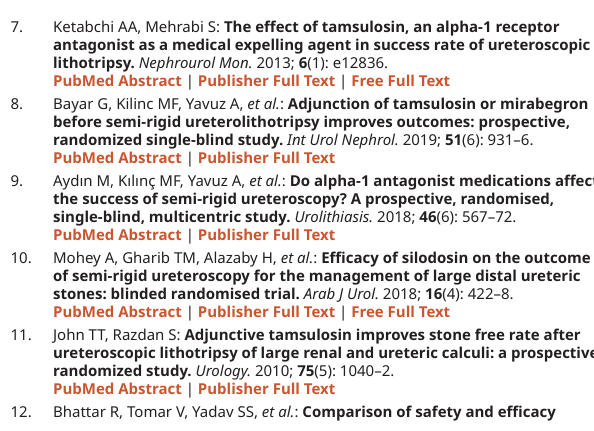
the conservative therapy of distal ureteral stones is advised in the appropriate clinical